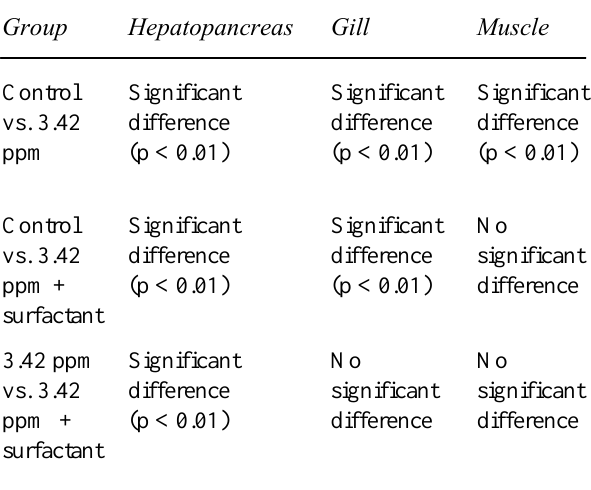
Table 3: Dose by tissue interactions of arsenic concentrations